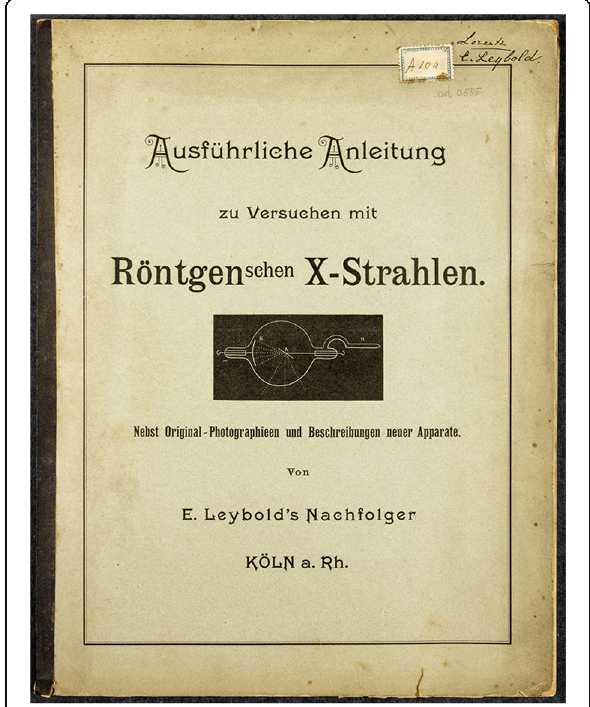
Fig. 1 Catalogue (1896) of X-ray equipment produced by the Leybold Company (Cologne, Germany) including a guide on how to take radiographs using this